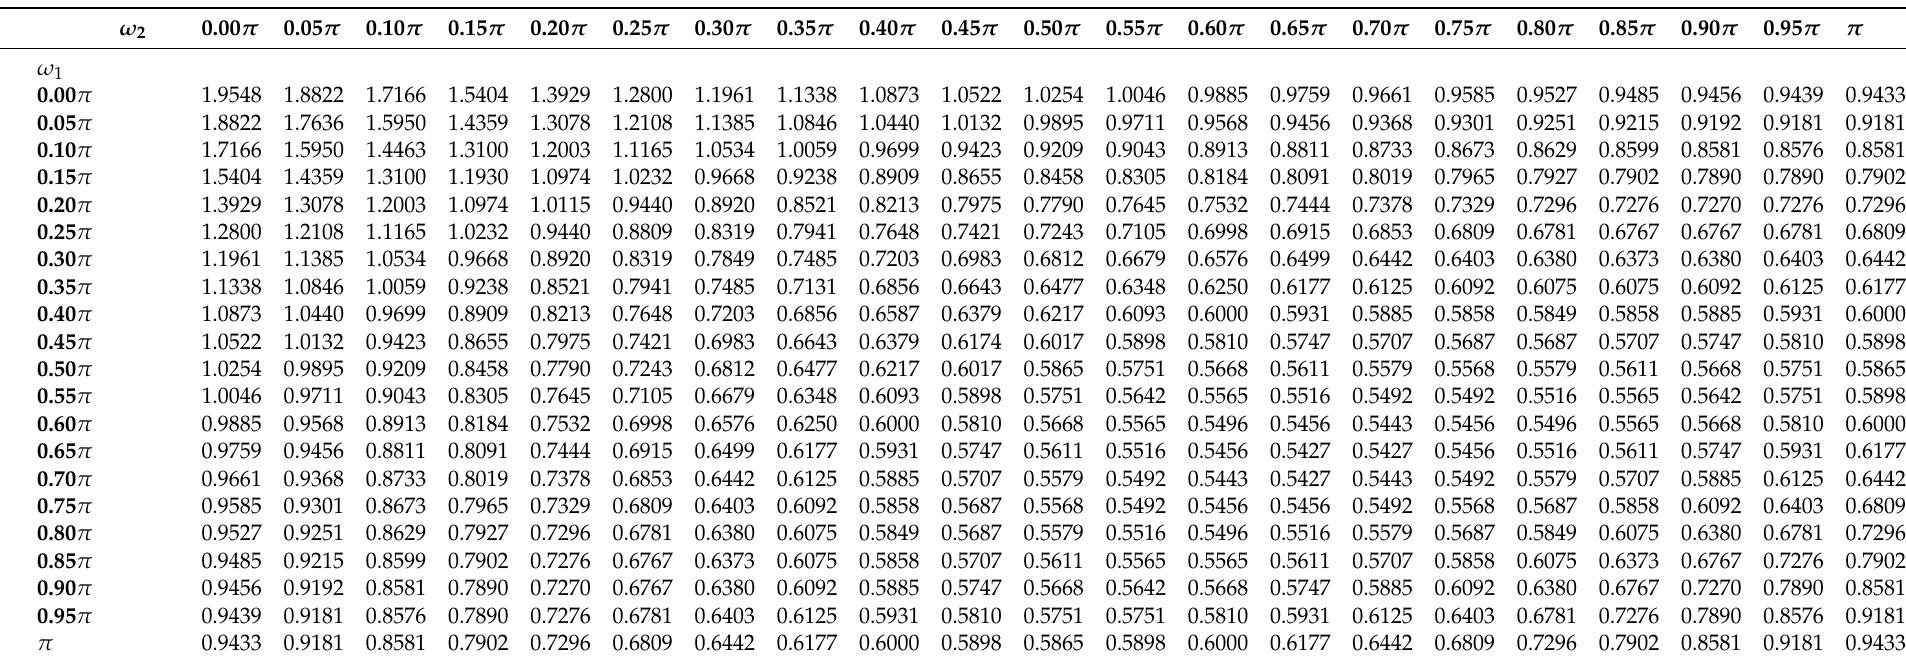
Table 2. Numerical values of theoretical normalized bispectrum modulus of DCGINAR(1) with α = 0.6, θ = 0.7 and µ =